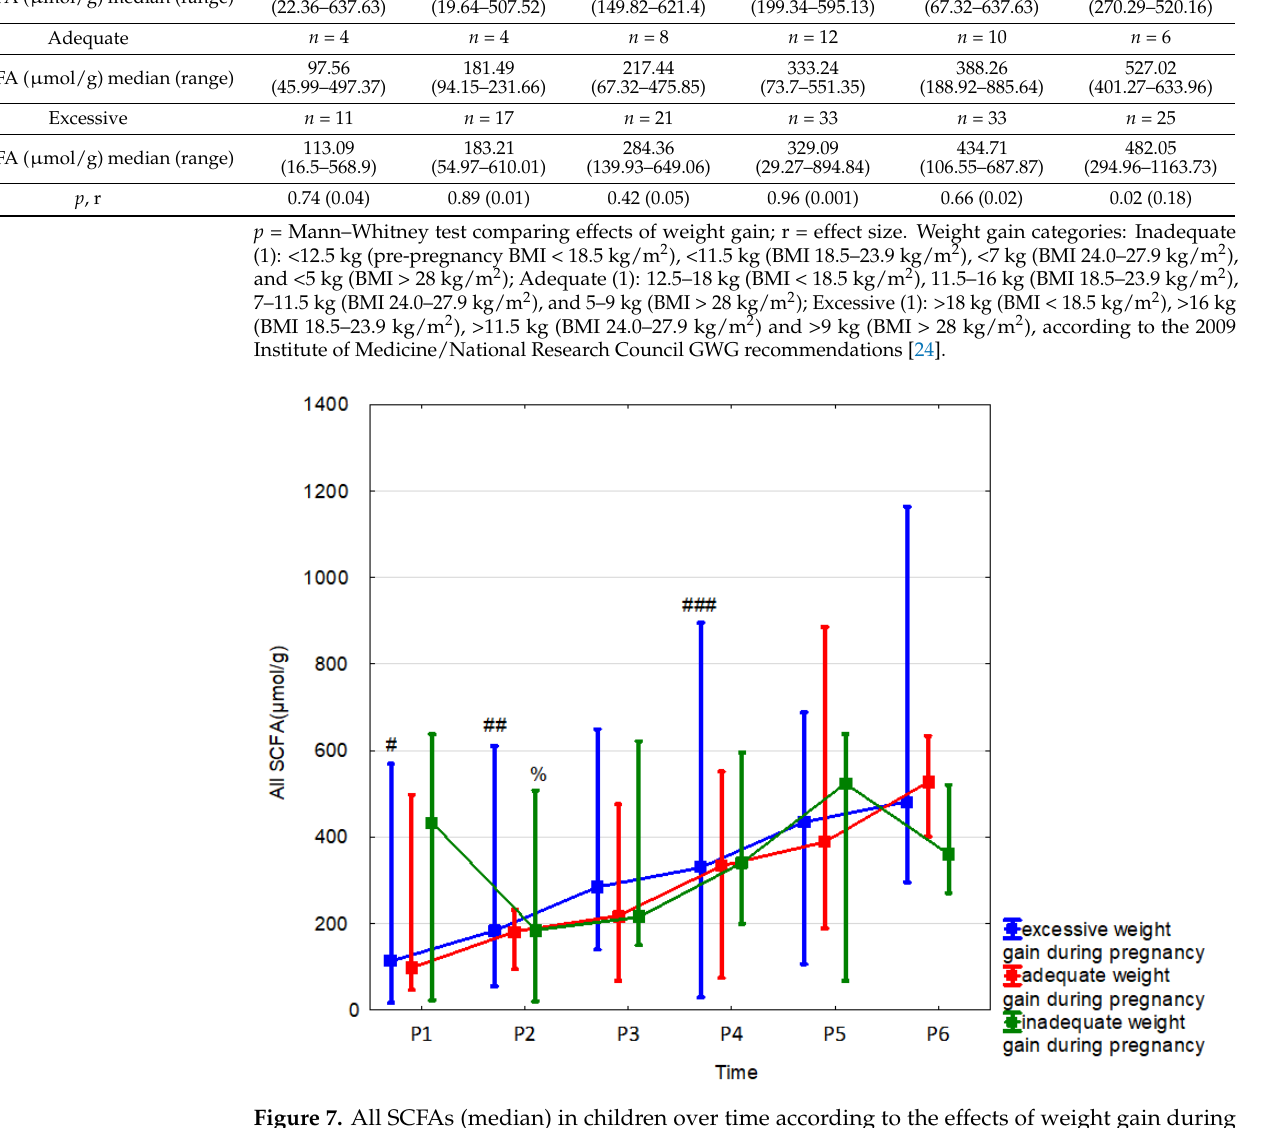
Table 9. Acetate content over time by sex .